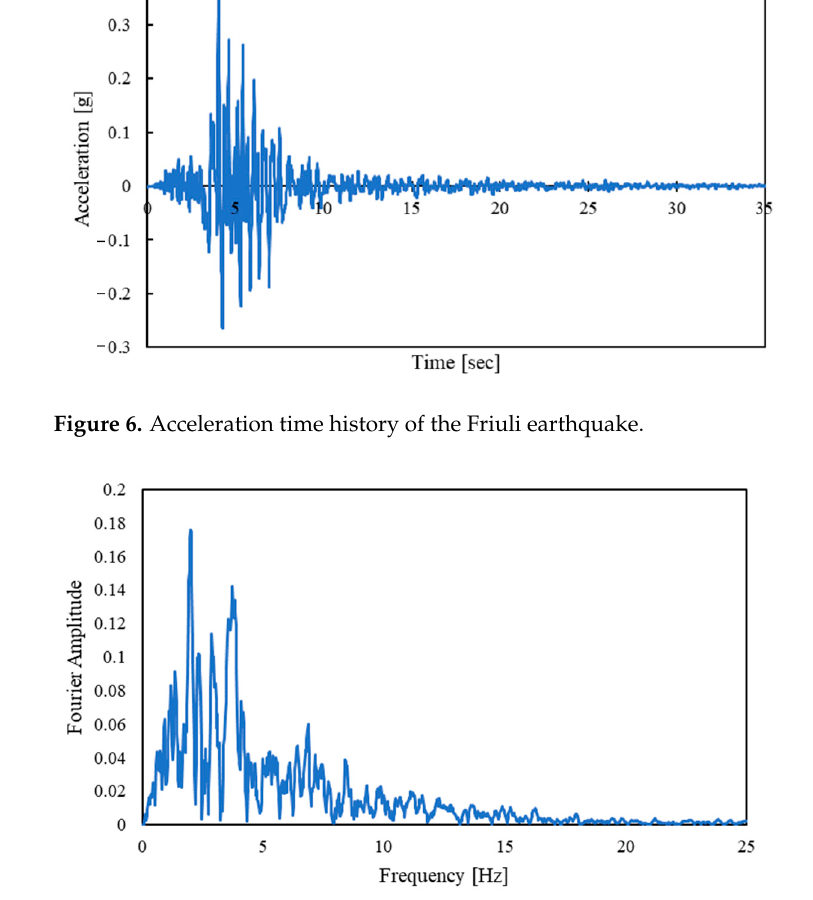
Figure 7. Fourier amplitude of the Friuli earthquake.